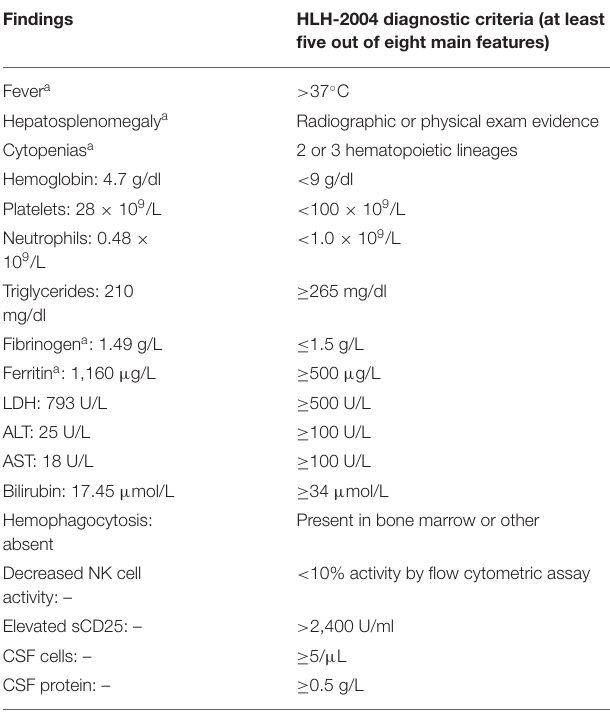
TABLE 1 | Patient’s clinical laboratory findings and HLH diagnostic criteria. Findings HLH-2004 diagnostic criteria (at least five out of eight main